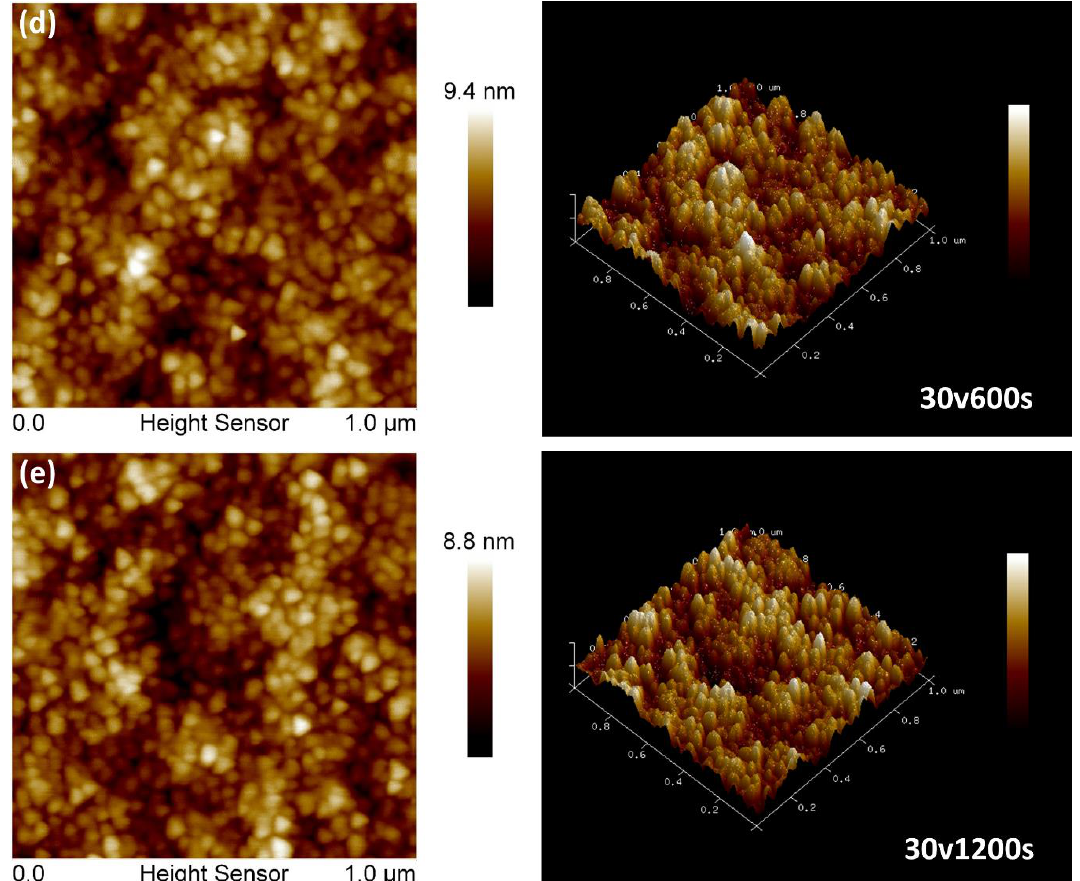
Figure 5. AFM image under 30 V with different duration ( a ) 100 s; ( b ) 200 s; ( c ) 400 s; ( d ) 600 s; ( e ) 1200 s.